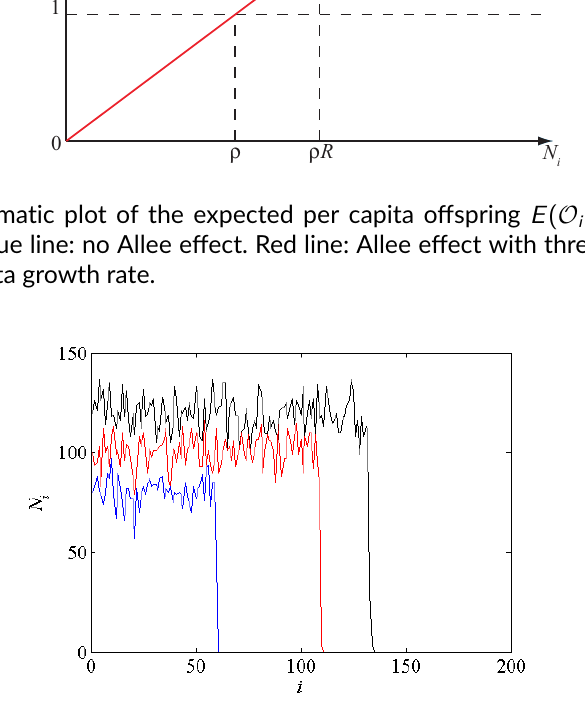
Figure 2 – Range expansions simulated with the IBMs. Black curve: null model, with K = 120 and probability of migration p 1 = 0.5 ; red curve: strong Allee effect, ρ = 20 and K = 100 , p 1 = 0.5 ; blue curve: density-dependent dispersal, τ = 500 , K = 80 , p 1 = 0.14 . In all cases, t = 150